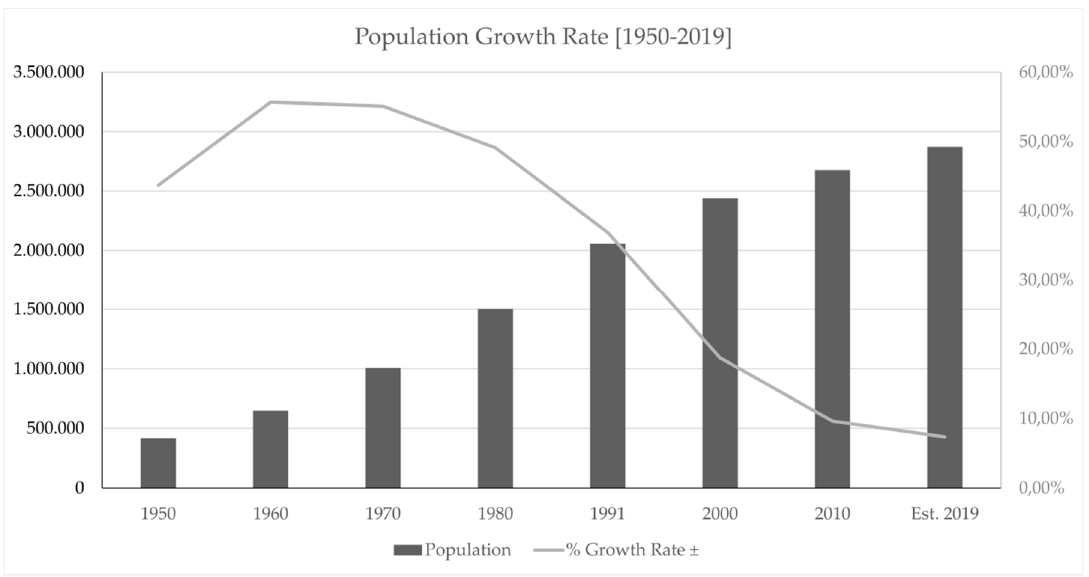
Figure 3. Overview of the case study area. Map of Alto do Cabrito and Marechal Rondon of Salvador City; Brazil (upper left); Salvador (lower left); case study neighborhoods (right). Produced by the authors. Data source: Brazilian Institute of Geography and Statistics (IBGE) and Municipality of Salvador.